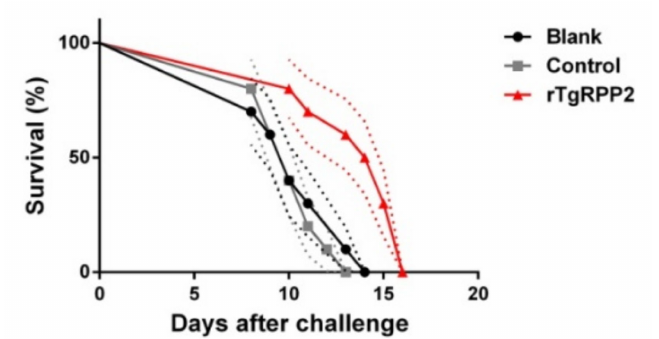
Figure 11. Mice survival rates after challenge infection with the T. gondii RH strain. Results were analyzed by the Kaplan–Meier test and compared based on the log-rank model. Values are shown as the mean ± standard deviation ( n = 10). The dotted lines represent standard